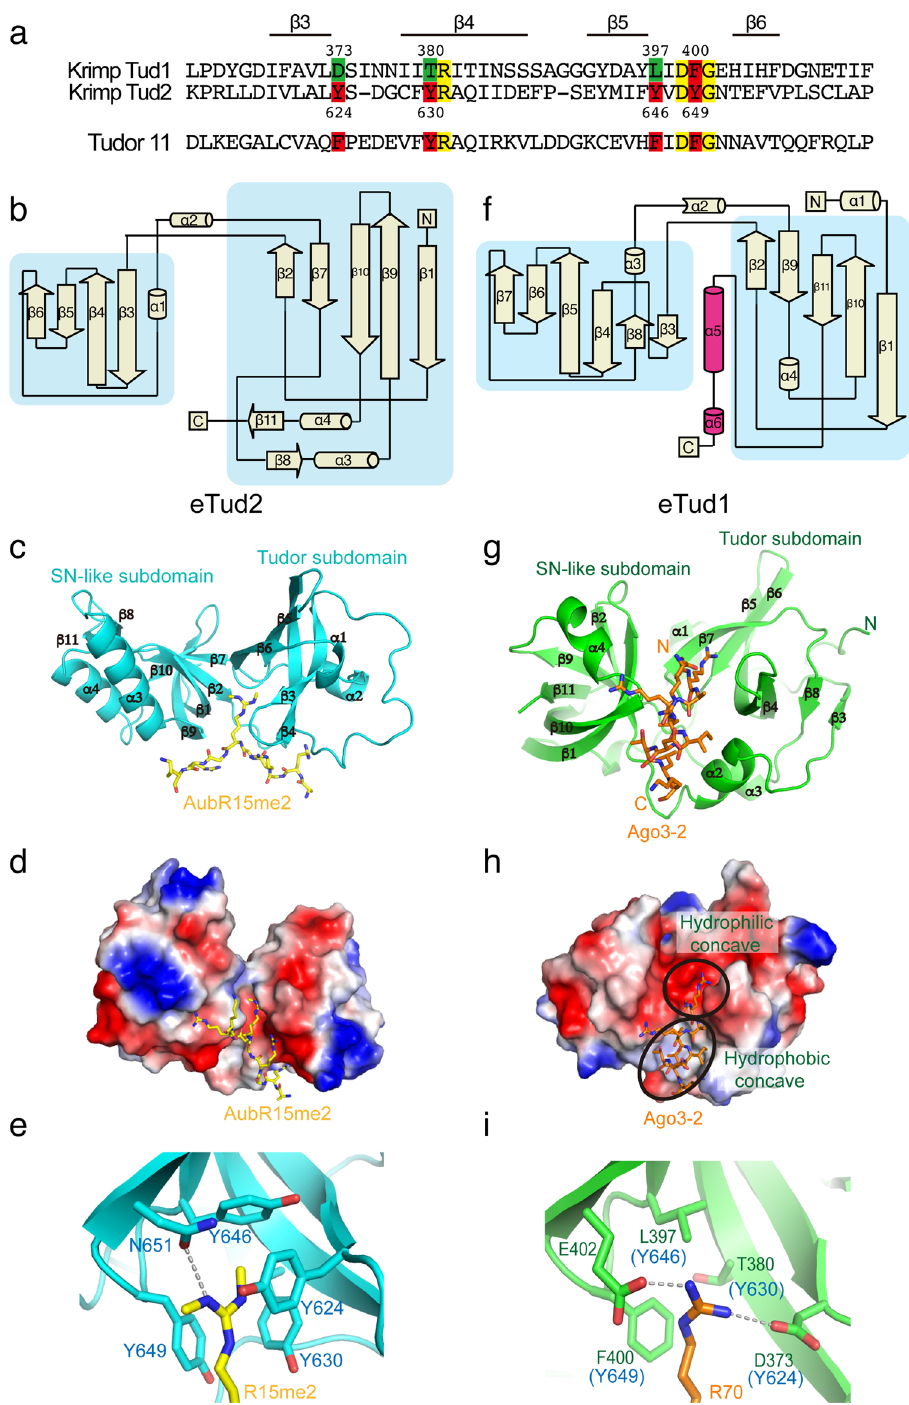
Fig. 2 Structure of Krimper eTud2-Aub and eTud1-Ago3 complex. a Krimper contains the canonical eTud2 domain and the non-canonical eTud1 domain. Alignments of Krimper Tudor domains with Tudor1 domain 11 are shown. Residues forming the me-Arg binding pocket (red) and corresponding residues in tud1 (green) are shown. Additional conserved residues marked yellow. Structural features are shown above. b Overall topology demonstration of Krimper eTud2 domain. The Tudor and SN-like subdomain are indicated. c Overall structure of the Krimper eTud2-Aub-R15me2 complex with the bound Aub- R15me2 peptide shown in yellow. d Electrostatic surface of eTud2 with bound Aub-R15me2 peptide shown in yellow. e Enlarged view of the eTud2 aromatic cage with R15me2 shown in yellow. f Overall topology demonstration of Krimper eTud1 domain. The Tudor and SN-like subdomain are indicated. The latch helix is marked magenta. g The overall structure of the Krimper eTud1-Ago3-2 complex with bound Ago3-2 peptide shown in orange. h Electrostatic surface of eTud1 with bound Ago3-2 peptide shown in orange. i Enlarged the view of the eTud1 binding pocket with inserted Ago3 R70 residue indicated in